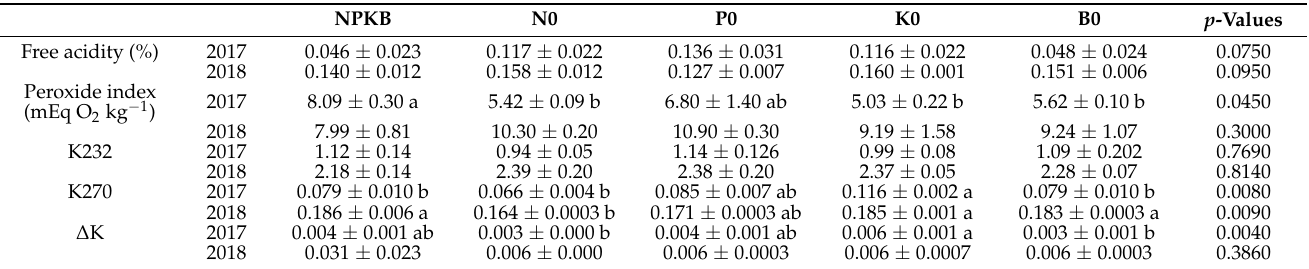
Table 6. Quality indices of olive oil from olive trees supplied with NPKB (control) and without N (N0), P (P0), K (K0) and B (B0) evaluated 3 months after the harvests of 2017 and 2018. NPKB N0 P0 K0 B0 p